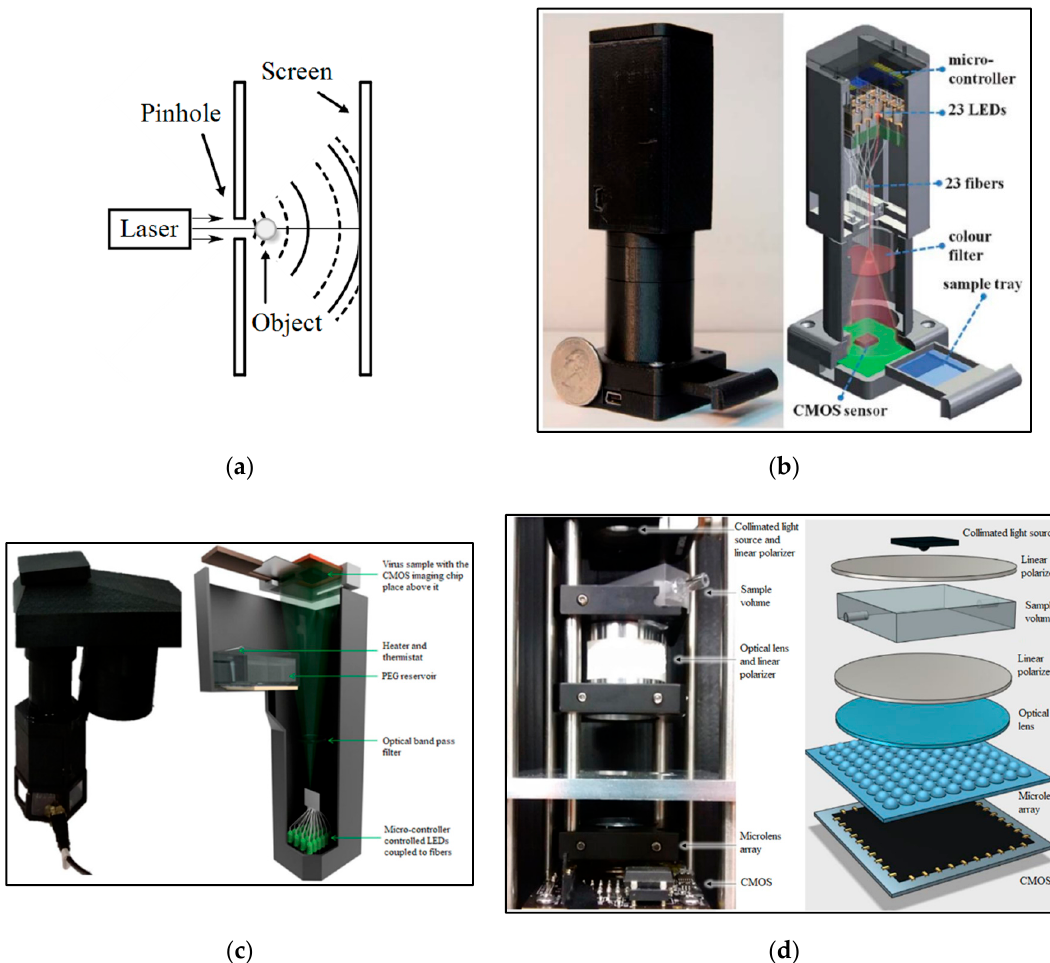
Figure 9. ( a ) Inline holographic microscopy, ( b ) The photograph and schematic of lens-free super-resolution microscope using a fiber-optic array reported in [43] , ( c ) The photograph and schematic of the portable lens-free microscope reported in [59], ( d ) The photograph and schematic of the image cytometer based on angular spatial frequency reported in [42] .